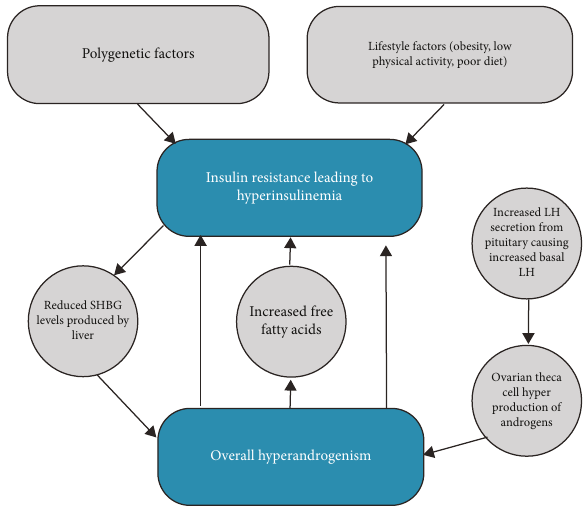
Figure 1: Hyperinsulinemia downstream effects on ovarian theca cell hyperproduction of androgens and subsequent pituitary feedback causing increased basal luteinizing hormone. Hyper- androgenism results in reduced SHBG (sex hormone binding globulin) (often used clinically for assessment of insulin resistance in